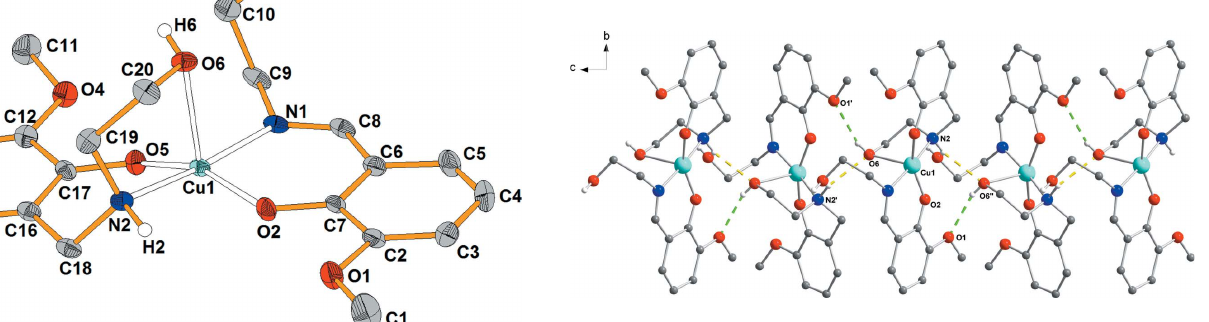
Figure 2 Fragment of the crystal packing of (I), showing intermolecular O6— H6 (cid:2)(cid:2)(cid:2) O1 (green) and N2—H2 (cid:2)(cid:2)(cid:2) O6 (yellow) hydrogen bonds forming chains along [001]. [Symmetry codes: ( 0 ) 1 (cid:5) x , 1 (cid:5) y , 1 (cid:5) 1 + z ]. 2